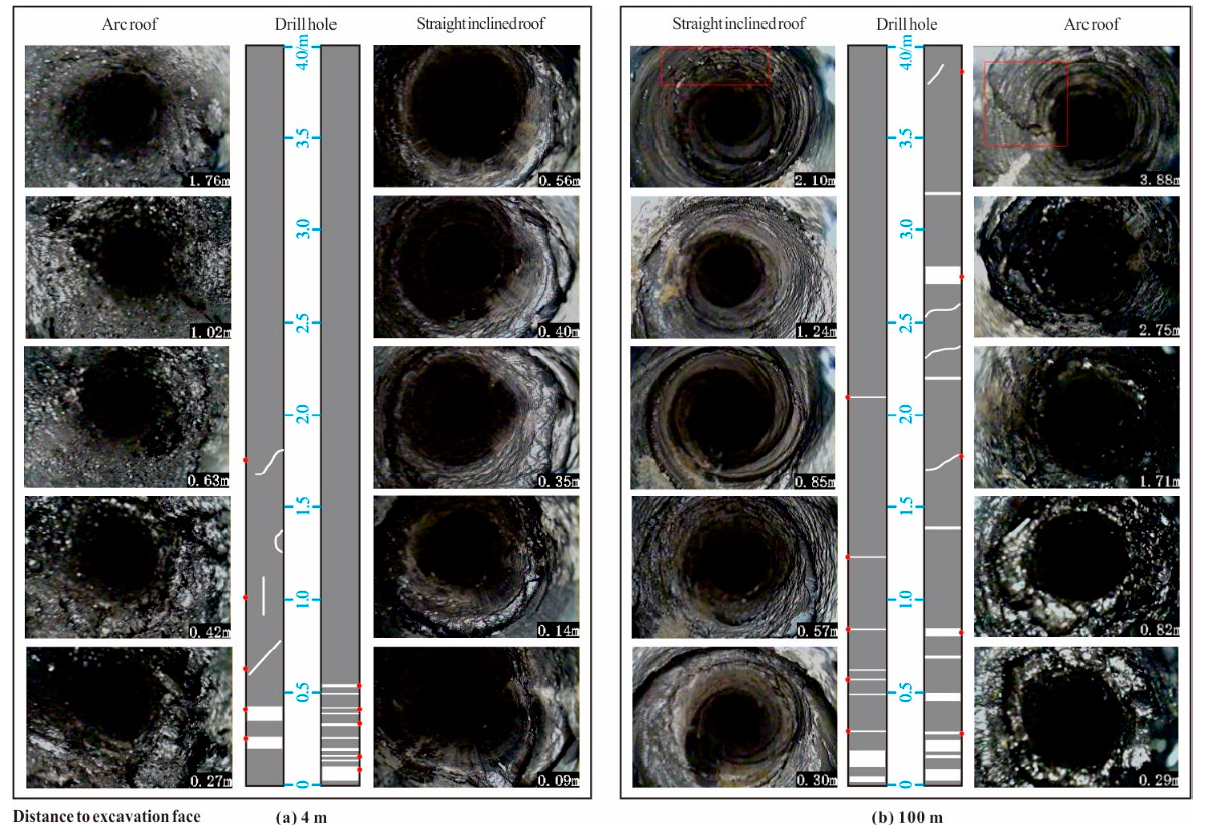
Figure 4. Distribution characteristics of cracks in the surrounding rocks of the roadway.